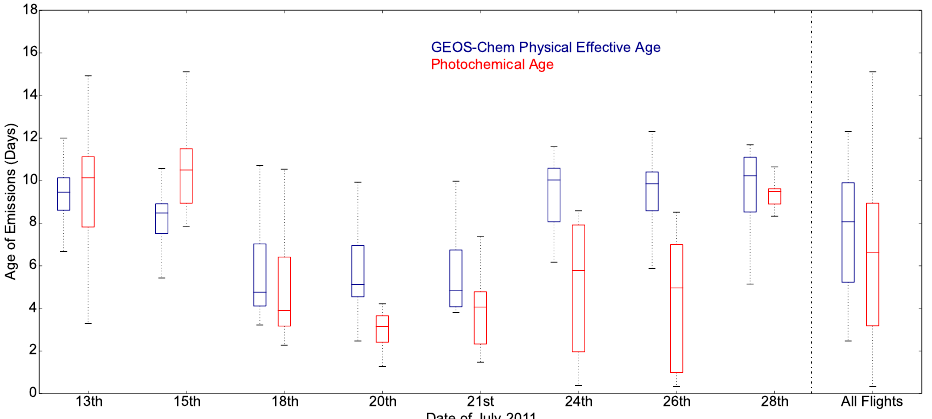
Figure 8. Box and whiskers plot of the age of air observed during individual BORTAS-B aircraft flights: photochemical age using BORTAS- B data (red) and effective age ¯ A using the GEOS-Chem model (blue). The box and whiskers plots for all flights are shown in the two right-hand columns. Within the box, the upper, middle, and lower horizontal bars denote the first quartile, the median, and the third quartile. The full range of data is shown by the